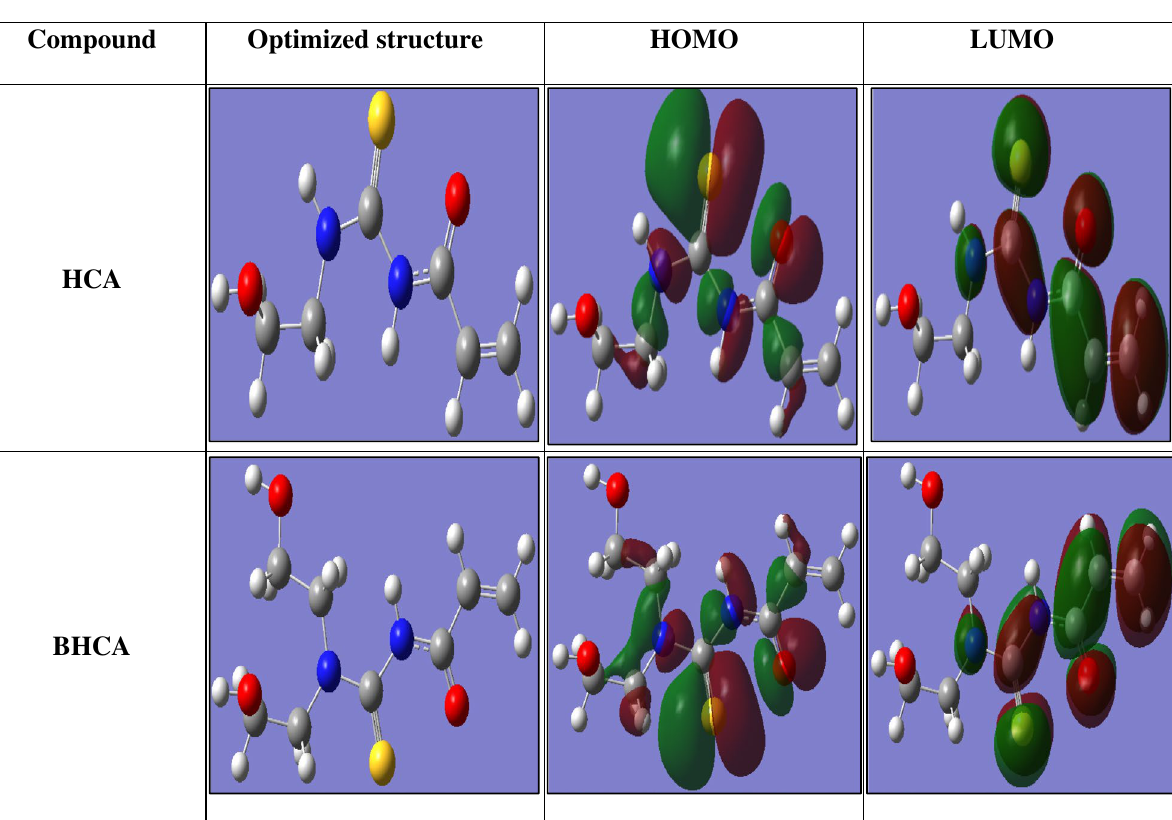
Figure 12. Molecular structure of the investigated composites, and its frontier molecular orbital density distribution (HOMO and LUMO) and the optimized molecular